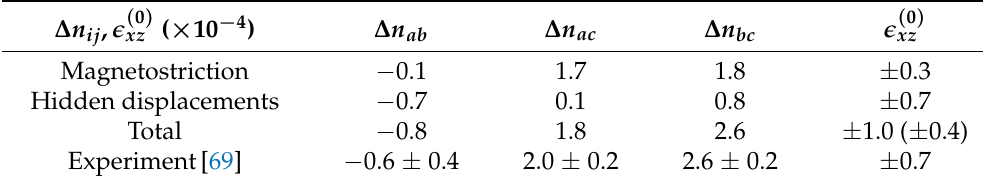
Table 7. Different contributions to the change in birefringeance at the Γ 4 − Γ 2 spin-reorientation